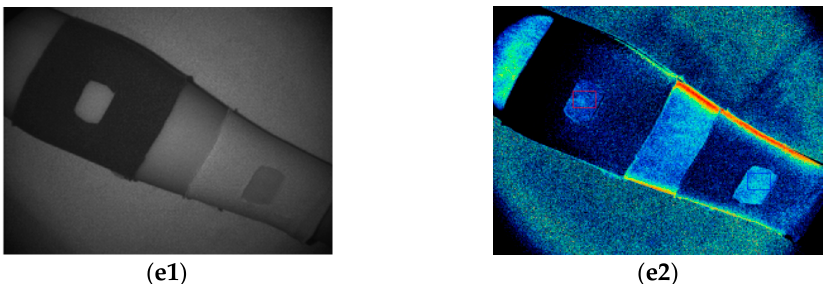
Figure 4. ( a1 ) When the sample was not covered; ( a2 ) blood-flow imaging when the sample was not covered; ( b1 ) when GP-0.0% sample was covered; ( b2 ) blood-flow imaging when covering GP-0.0% sample; ( c1 ) when GP-0.1% sample was covered; ( c2 ) blood-flow imaging when covering GP-0.1% sample; ( d1 ) when GP-0.2% sample was covered; ( d2 ) blood-flow imaging when covering GP-0.2% sample; ( e1 ) when GP-0.8% sample was covered; ( e2 ) blood-flow imaging when covering GP-0.8% sample.